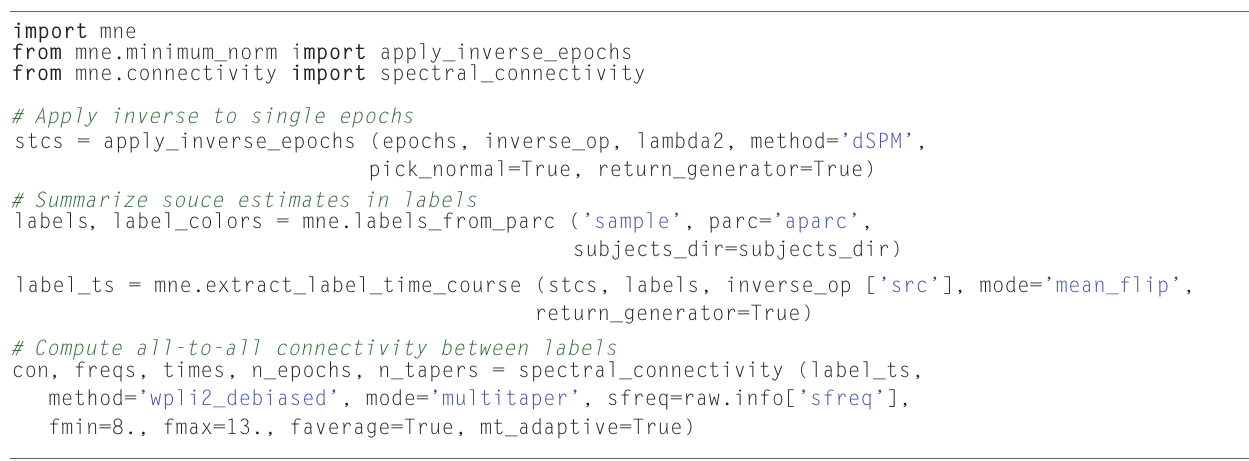
Table 4 | Connectivity estimation between cortical regions in the source